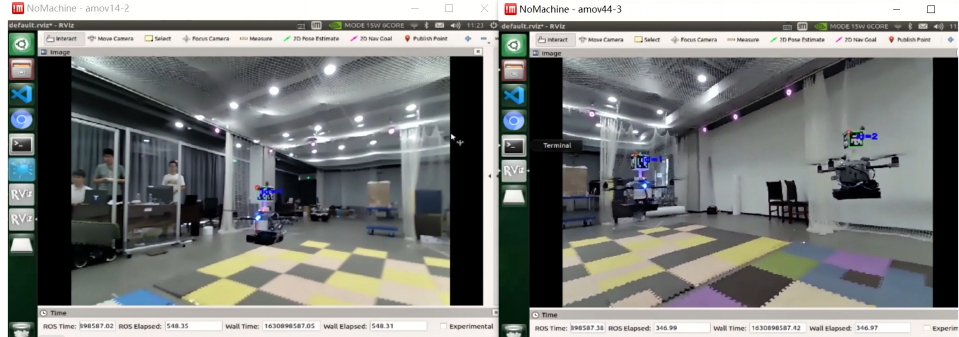
Figure 18. First-person view of the quadrotors during